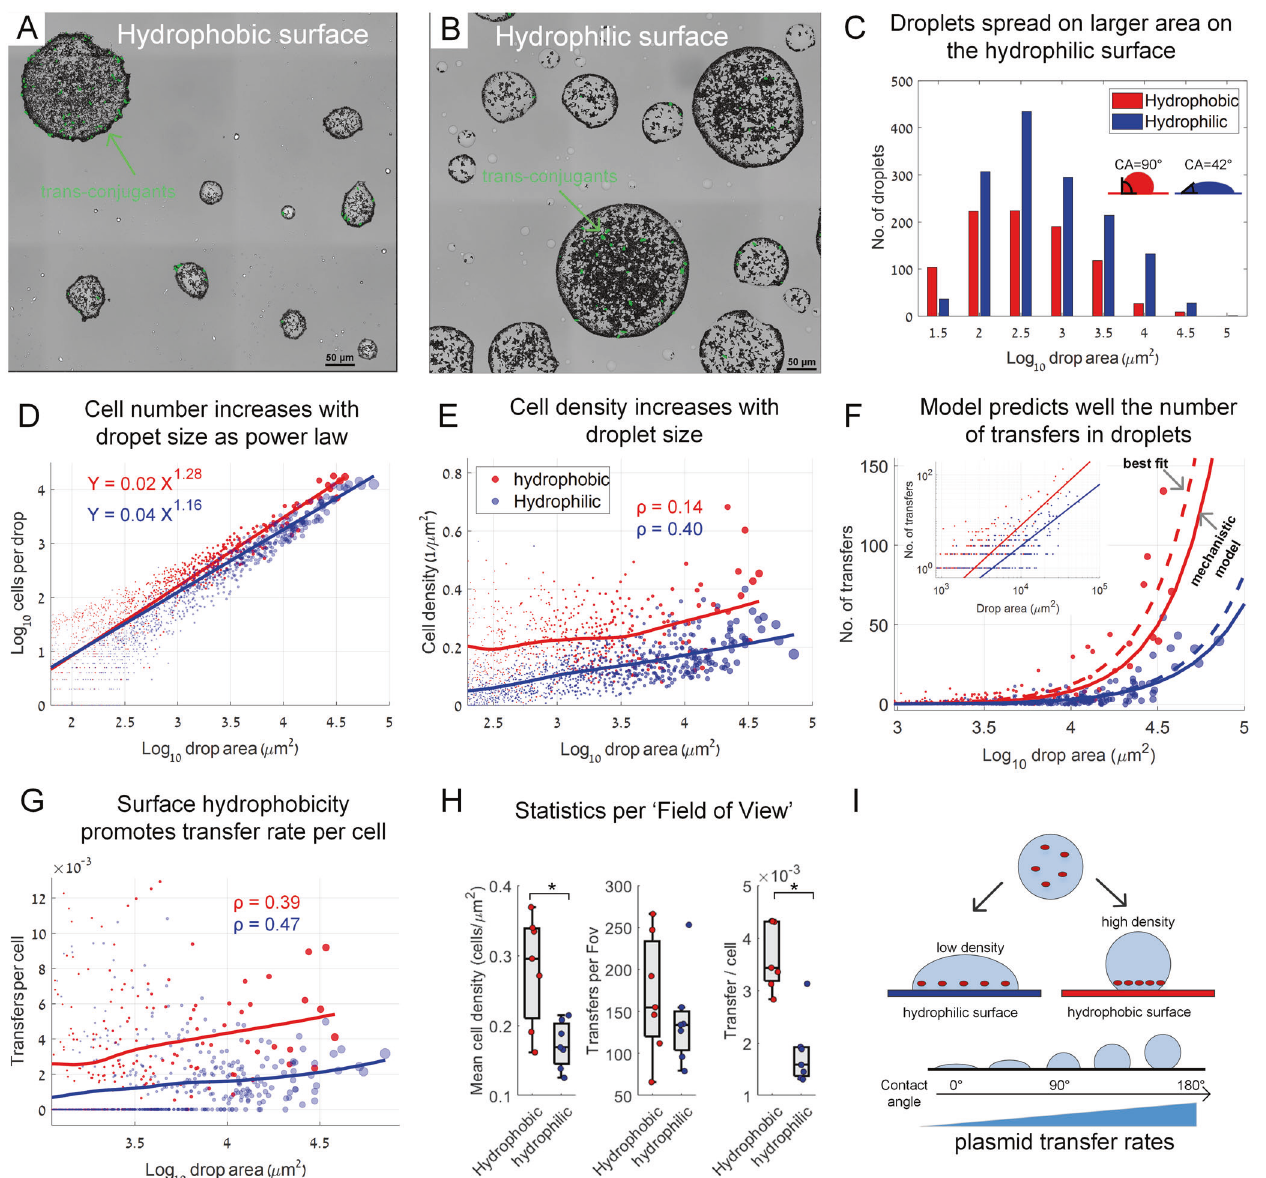
Fig. 2 Surface hydrophobicity effect on plasmid transfer rates. A A representative section of a hydrophobic surface covered by sprayed droplets at 6 h after spraying. Green cells are trans-conjugants. B Same as in ( A ), but on a hydrophilic surface. C Droplet area histograms (area refers to area of the liquid-solid interface). Contact angles ( CA ) were measured as described in SI. D Cell numbers in individual droplets including donors, recipients, and trans-conjugates. Circle size re fl ects droplet area. Axis plotted on a log-log scale (dataset includes 2518 droplets). E Surface cell density in individual droplets. Line represents average smoothing (LOESS). ρ represents Spearman rank correlation coef fi cients ( P = 0.0294 for the hydrophobic experiments, and P < 10e-10 for the hydrophilic one; ρ calculated for drops with A > 10 3 µm 2 ). F Number of transfer events ( T e ) as a function of droplet area: Circles represent experimental data. Solid lines: mechanistic model (see SI). Dashed line: best- fi tted line based on data ( fi tted as a power function, SI). Inset: same data, but at log-log scale. G Transfer events per cell ( T c ) as a function of droplet area. Solid lines represent average smoothing (LOESS). ρ represents Spearman rank correlation coef fi cients ( P = 3.44e- 10 for the hydrophobic experiment, and P < 10e-10 for the hydrophilic one; ρ calculated for drops with A > 10 3 µm 2 ). H Statistics per entire surface sections (each of 1.6 mm × 1.6 mm). Boxplot represents median and 25%, 75% percentiles. Statistical comparisons were based on two- sample t -test yielding P = 0.0058, P = 0.41, and P = 1.34e-04 for the three comparisons respectively. * indicates statistical signi fi cance